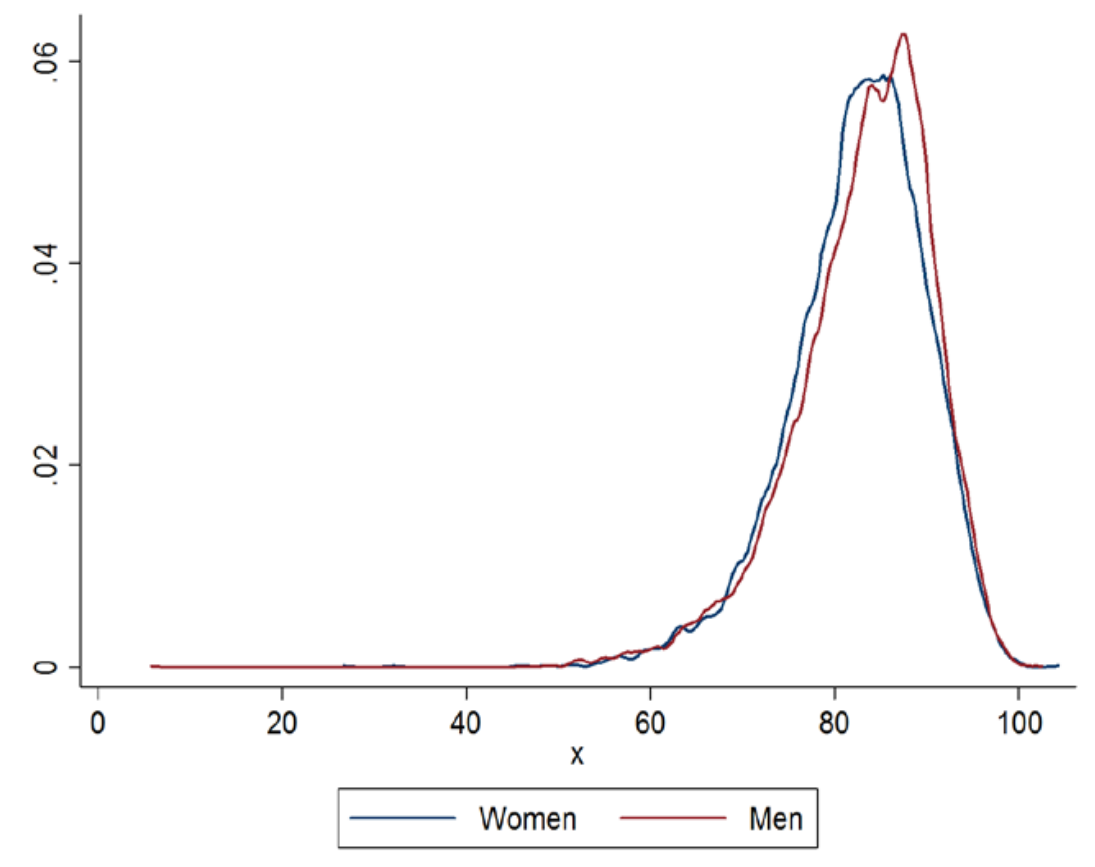
Figure 1: Distribution of Academic Scores, by Gender,